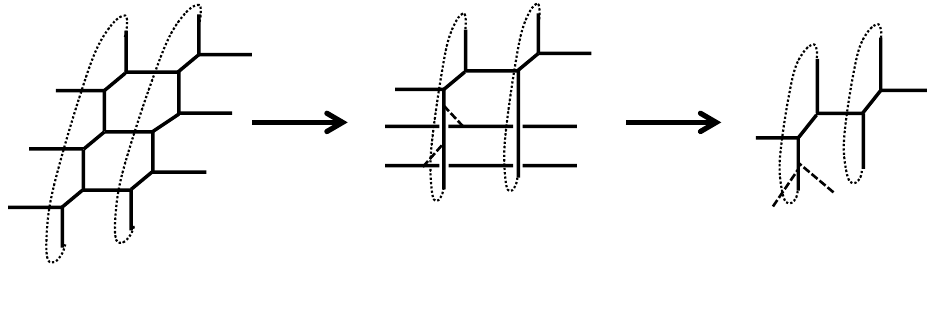
Figure 6 . The geometric transition.